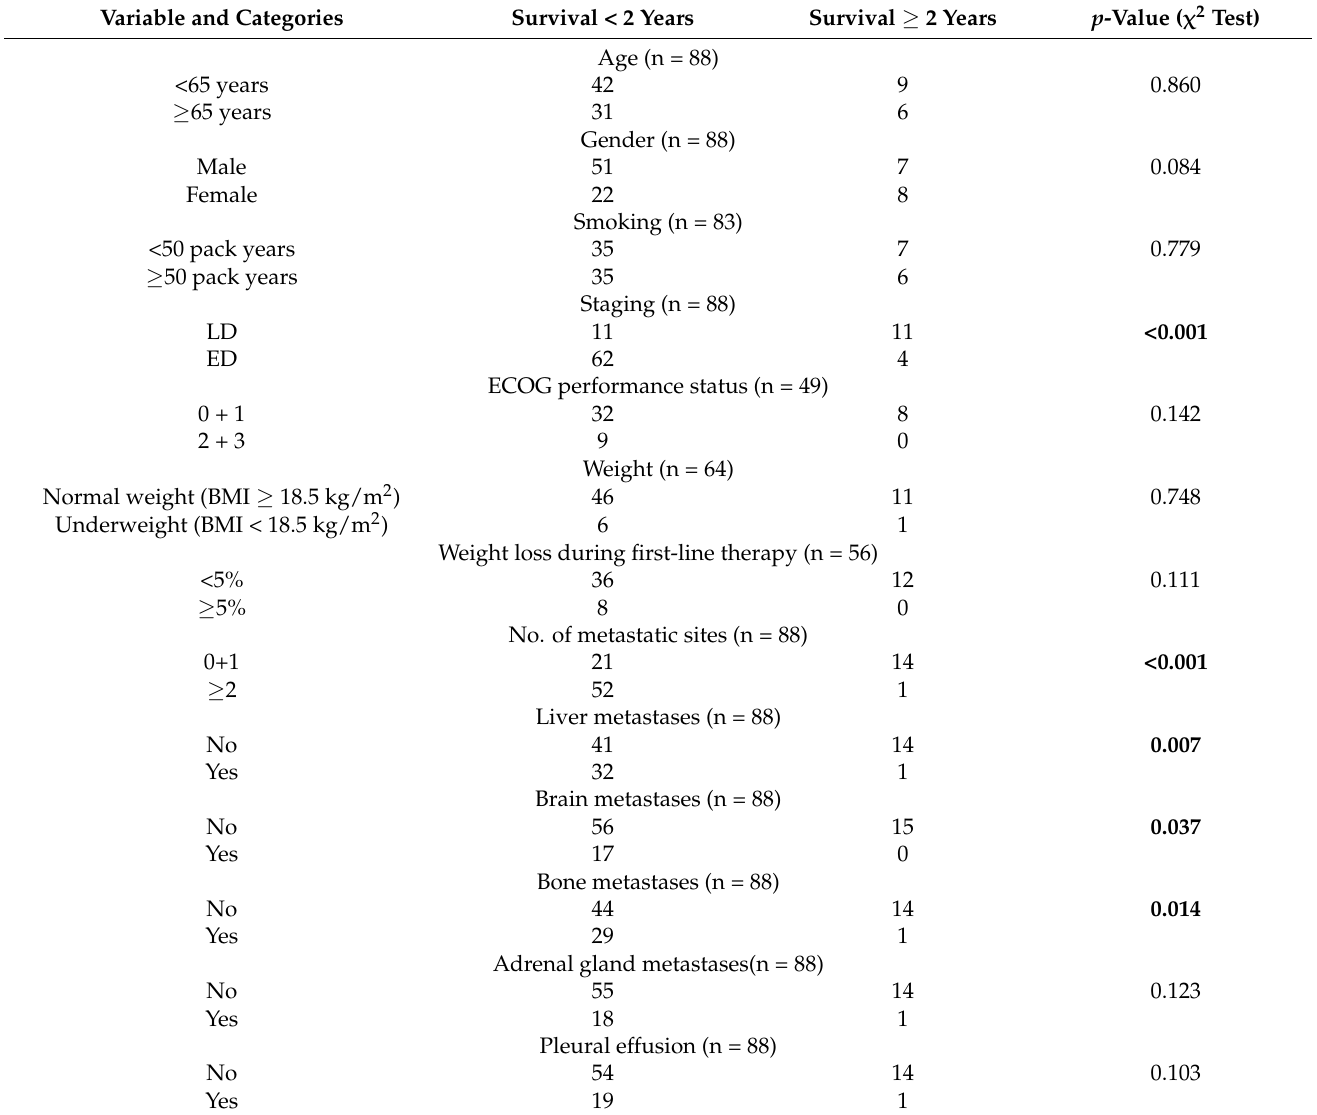
Table 5. Baseline characteristics and their correlation to long-term